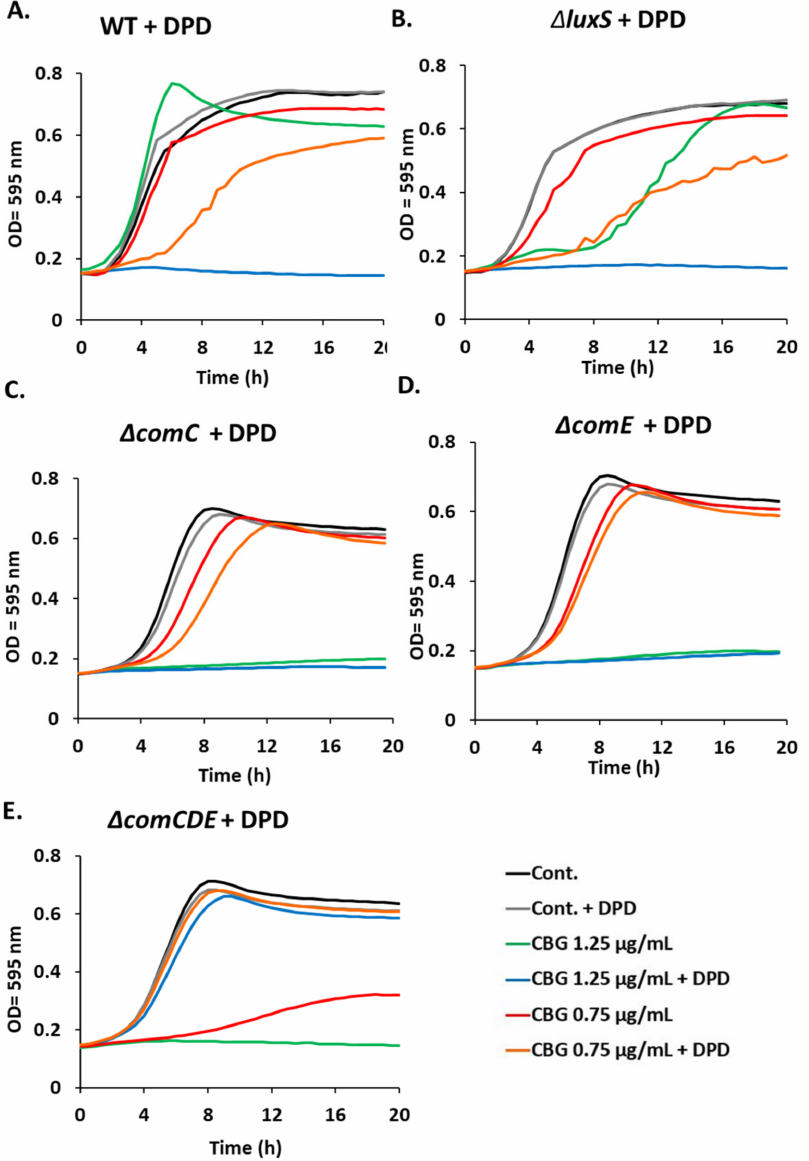
Figure 3. DPD increased the susceptibility of WT and ∆ luxS strains, but not of the ∆ comC and ∆ comE strains to CBG. ( A – E ). Kinetic studies of the planktonic growth of the various S. mutans strains incubated in the absence or presence of CBG (1.25 µ g/mL) and/or DPD (pre-AI-2) (5 µ M) with an initial OD 600nm of 0.1. ( A ). WT; ( B ). ∆ luxS ; ( C ). ∆ comC ; ( D ). ∆ comE ; and ( E ). ∆ comCDE . n =